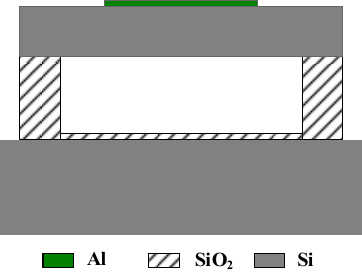
Figure 2. Schematic diagram of CMUT cell cross-section.